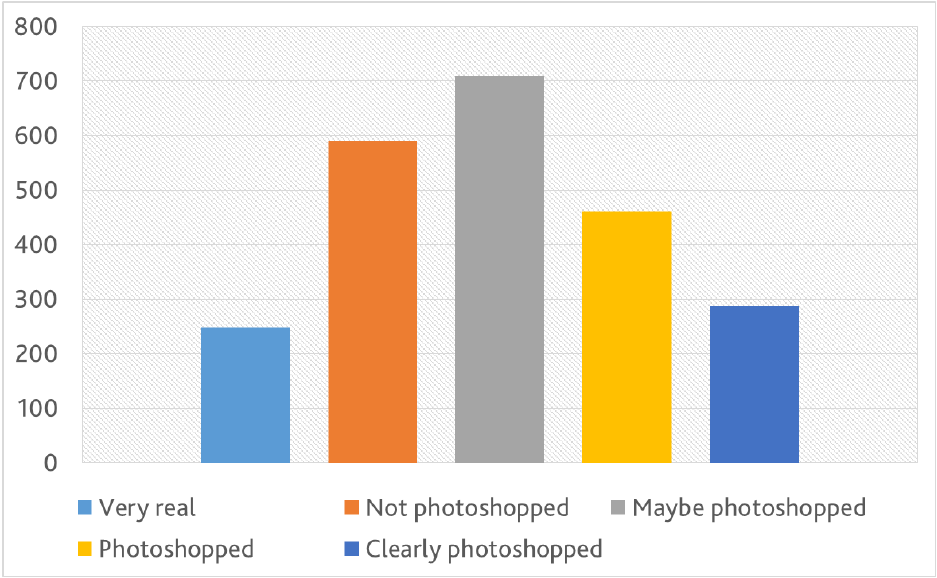
Figure 6. Frequency histogram of participants’ answers to the question: “ Does the picture look photoshopped?